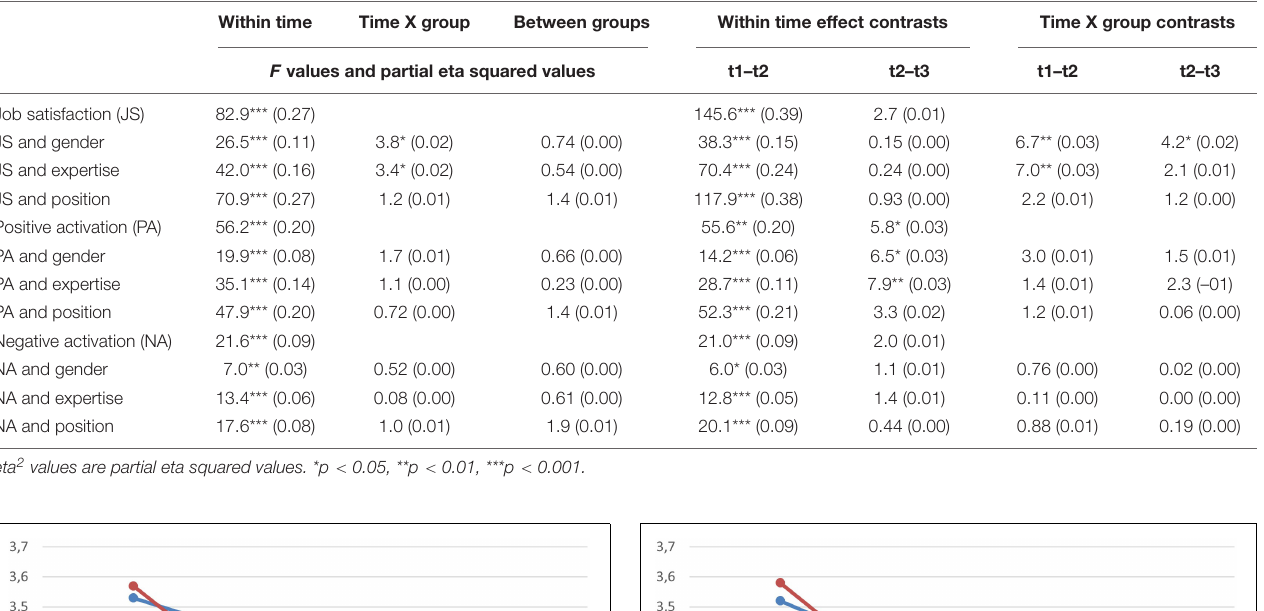
TABLE 2 | Repeated measures analysis of variance results for all three outcomes.